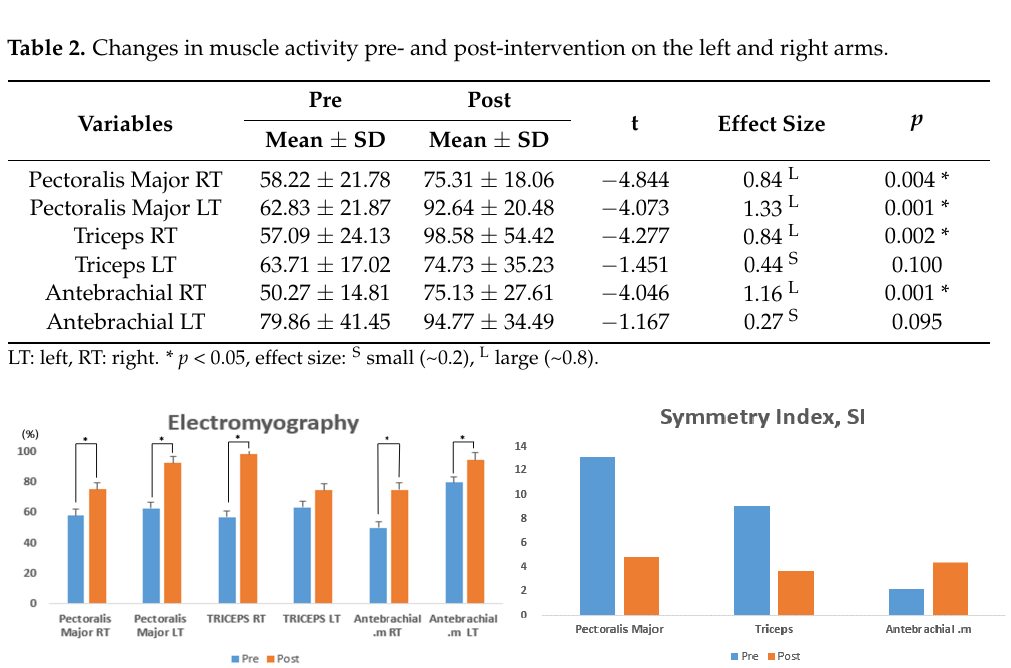
Figure 3. Comparison of muscle activity pre- and post-intervention with 8 weeks of EMS training.